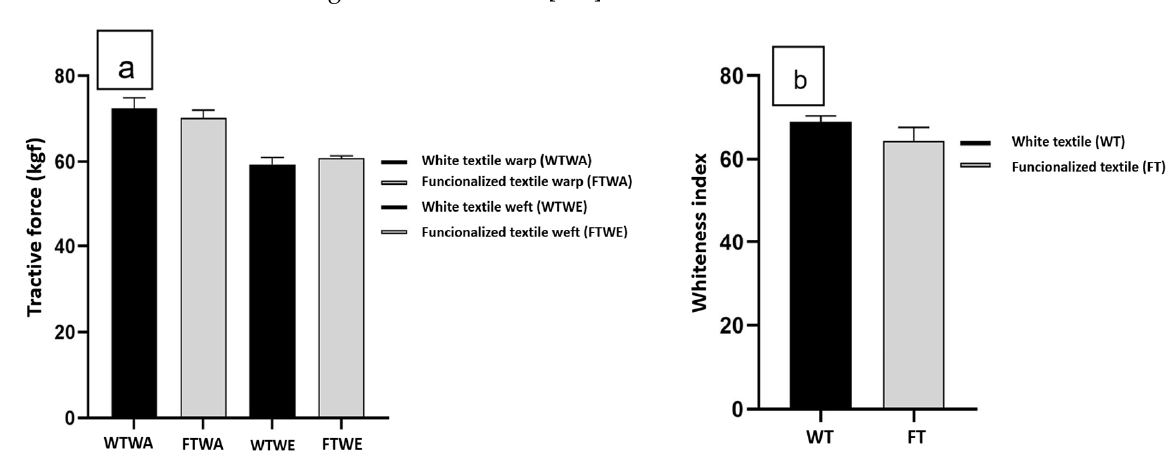
Figure 7. Tensile strength for textile warp and weft ( a ) and whiteness index ( b ) results for the control and functionalized fabric with AgNPs-CMC nanocomposite.